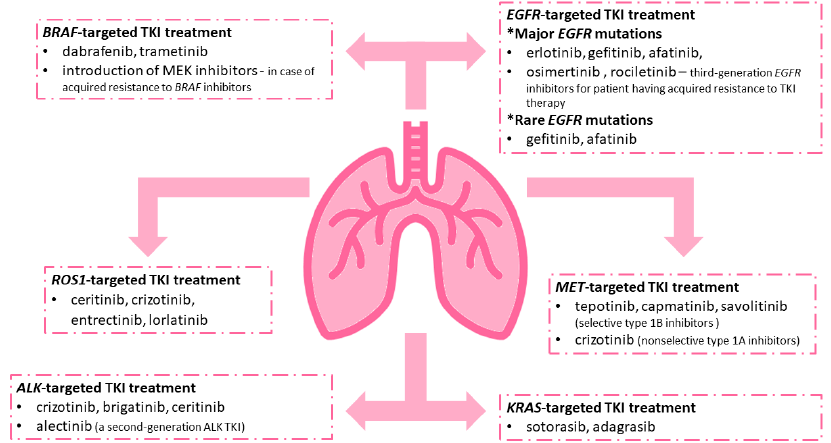
Figure 1. Examples of tyrosine kinase inhibitors (TKIs) used in NSCLC patients with certain changes in genes including the EGFR , ALK , ROS1 , BRAF , MET , and KRAS genes.